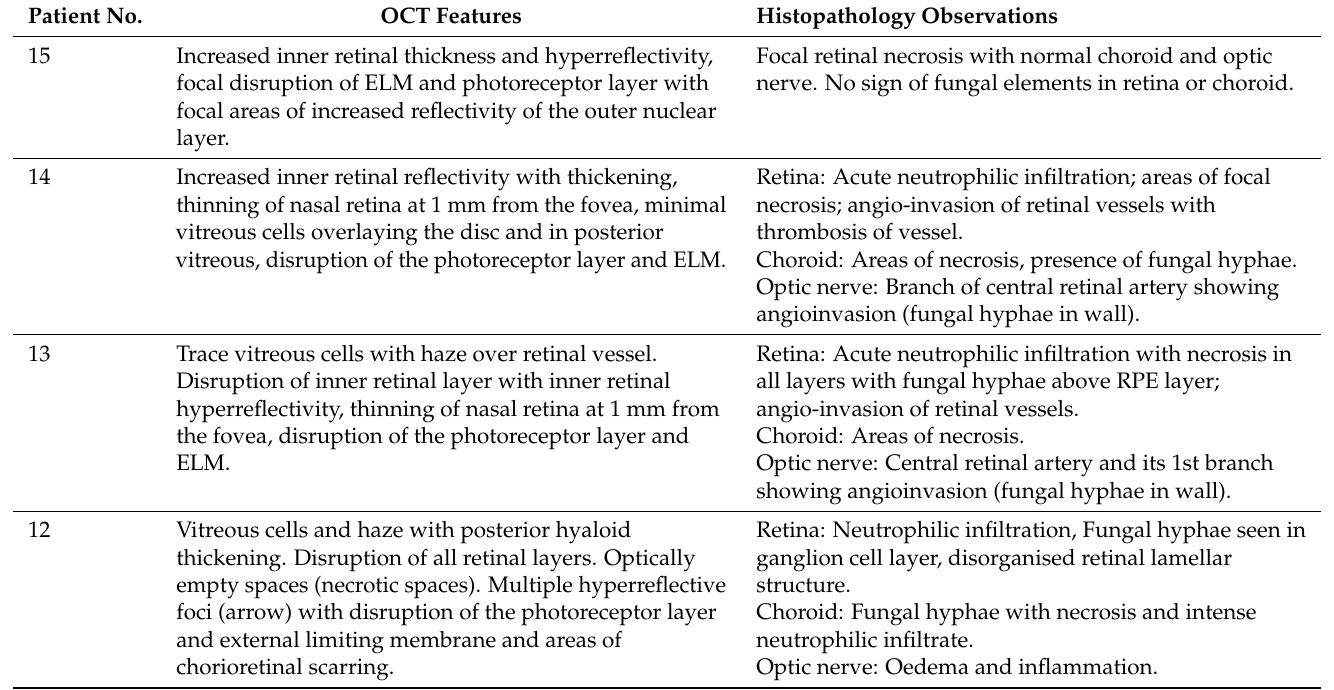
Table 4. OCT and histopathology findings in patients undergoing orbital exenteration for vison- threatening